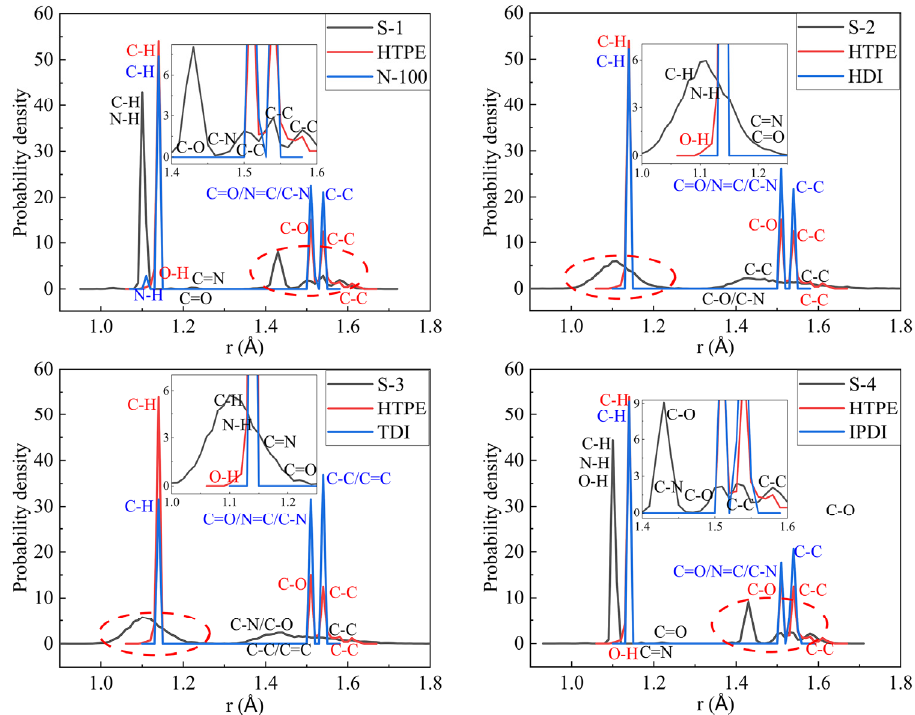
Figure 5. The bond-length distributions of HTPE binder systems.